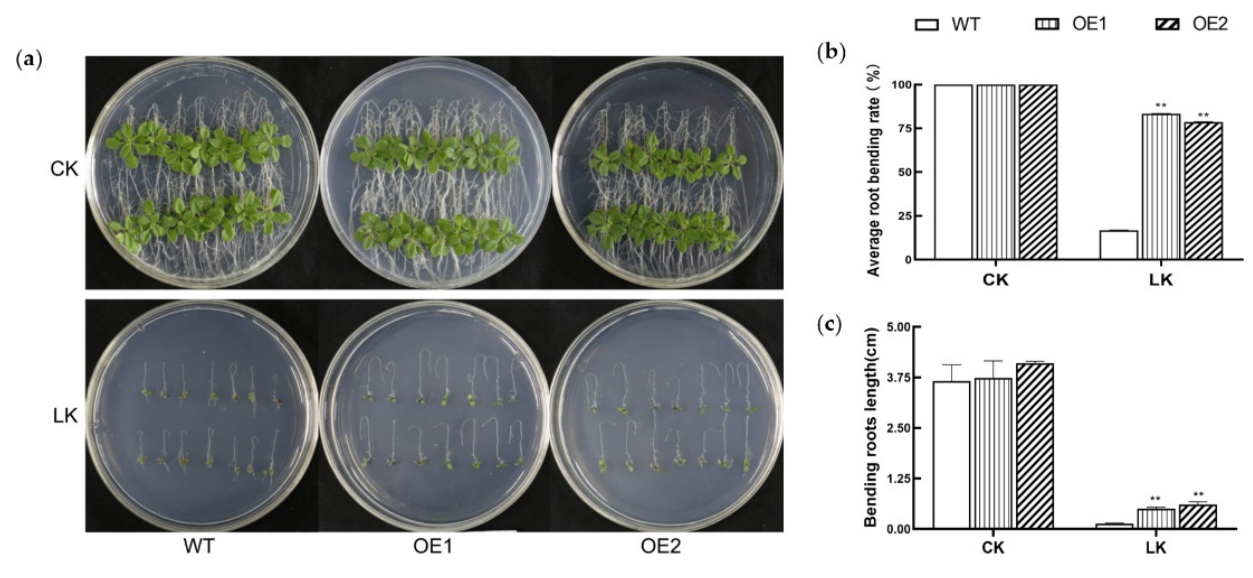
Figure 2. Responses of KIbB1 transgenic and WT seedlings cultured on 1/2 MS medium with normal and low-K + conditions. ( a ) Phenotypes of the tested plants. Rate ( b ) and length ( c ) of root bending of the tested plants under different conditions. Data are presented as means ± SE ( n = 3). ** indicates a significant difference at p < 0.01.